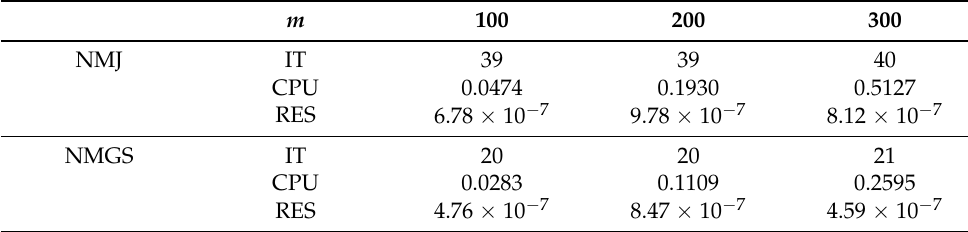
Table 3. Numerical results for Ω = 1.2 I